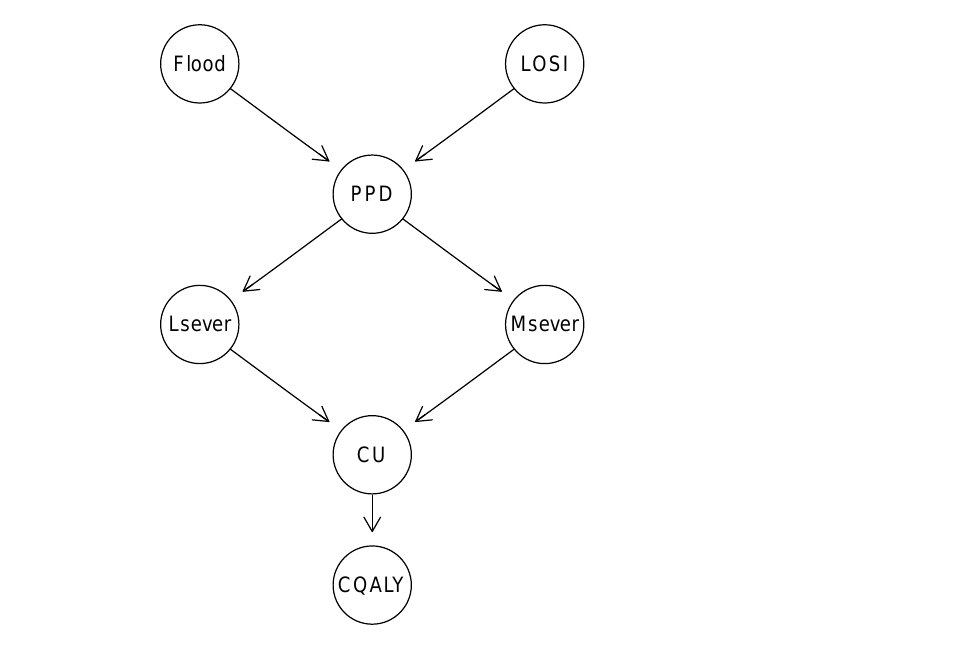
Figure 4. Static Bayesian network to evaluate the effect of flood interventions upon mental health where LOSI indicates the loss of sentimental items, PPD indicates the prevalence of probable depres- sion, Msever and Lsever indicate the more severe depression and less severe depression respectively, CU indicates the change in utility and CQALY indicates the change in QALY. Table 1. The elicited probabilities and corresponding source of data for each node of BN illustrated in Figure